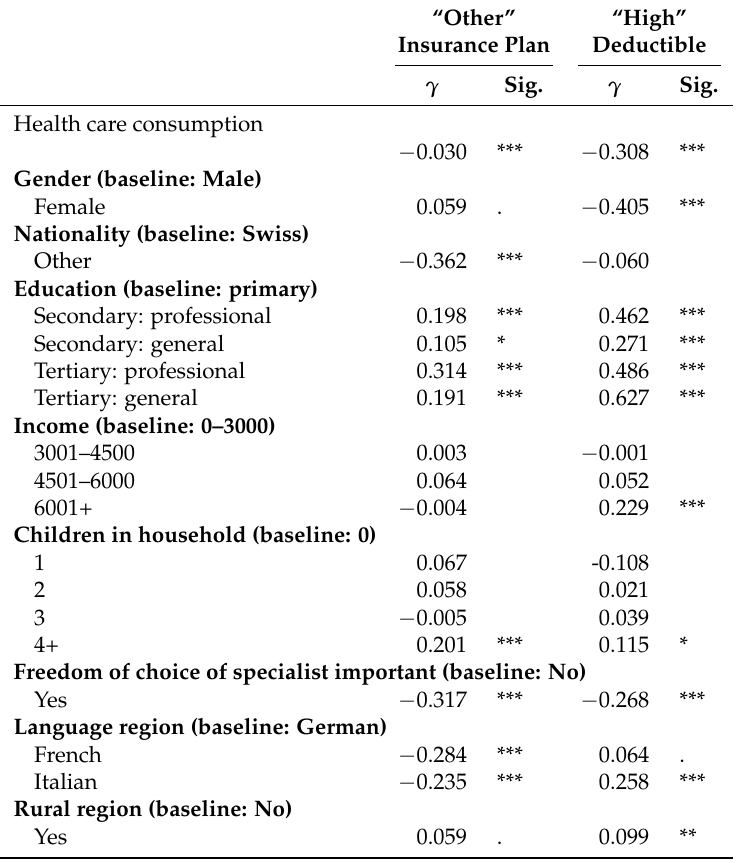
Table 9. Results for regression models for health insurance demand (Equations (5) and (6)).